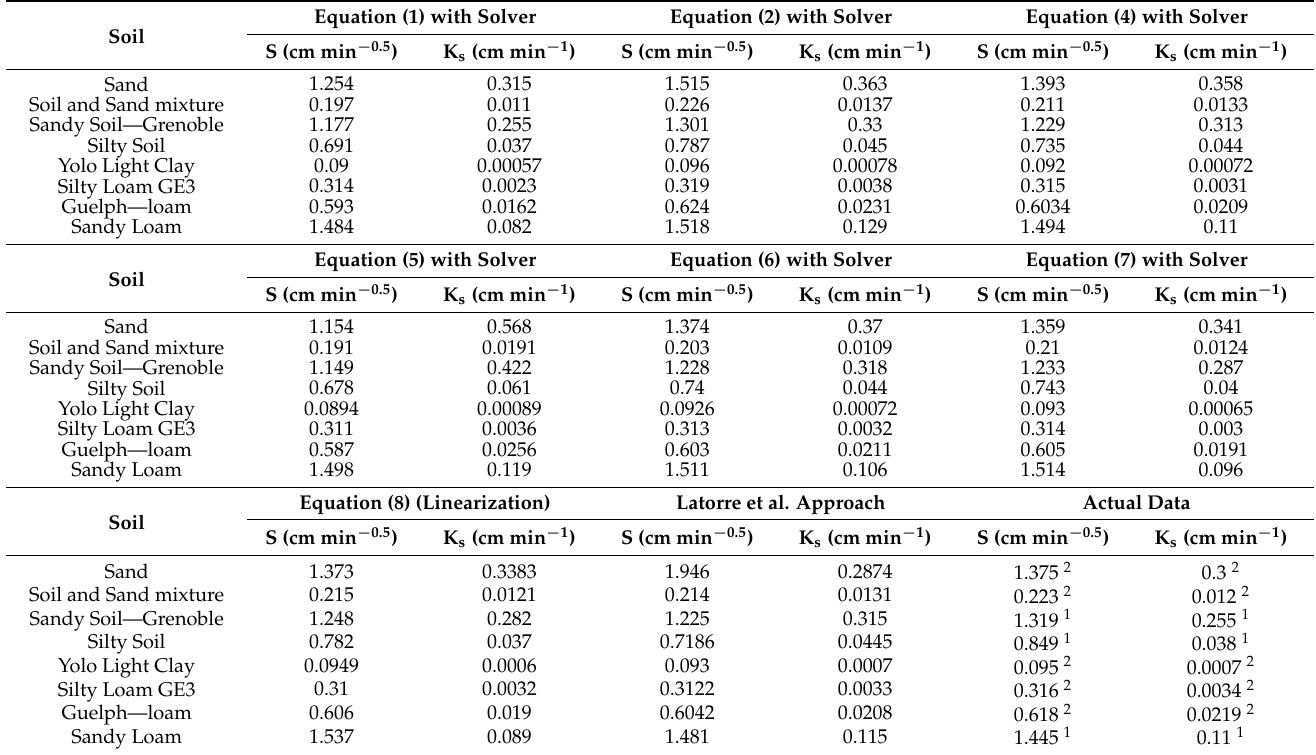
Table 2. Predicted values of S and K s from various infiltration equations using different methods, as well as the corresponding actual values (measured or numerical) for all soils